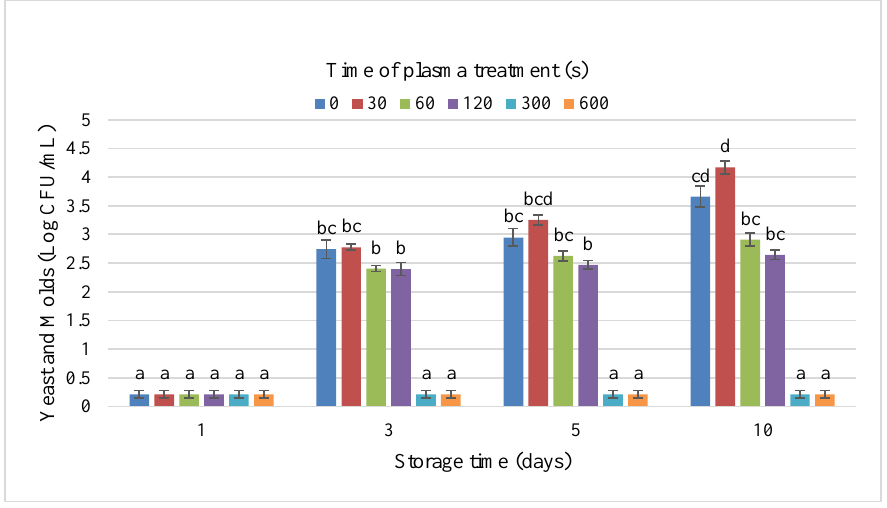
Figure 3. Visually, no mold growth was observed on these samples until day 10 of storage.